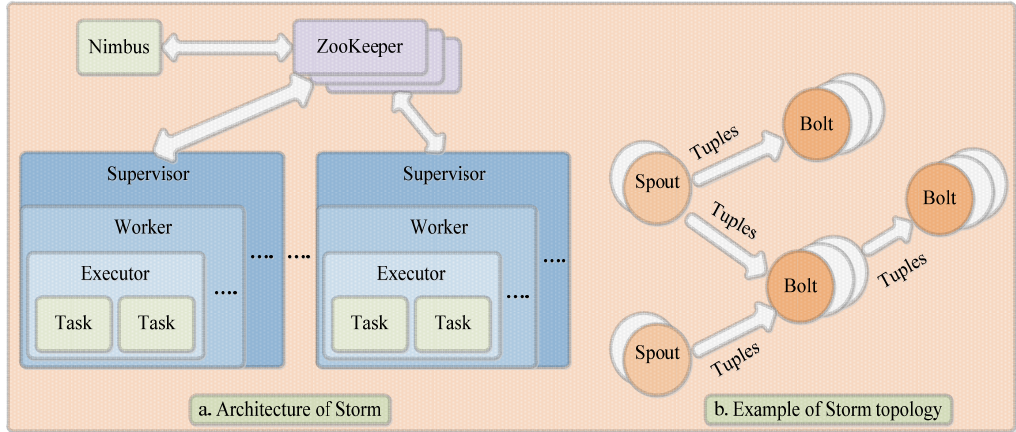
Figure 12. Architecture and topology of storm.